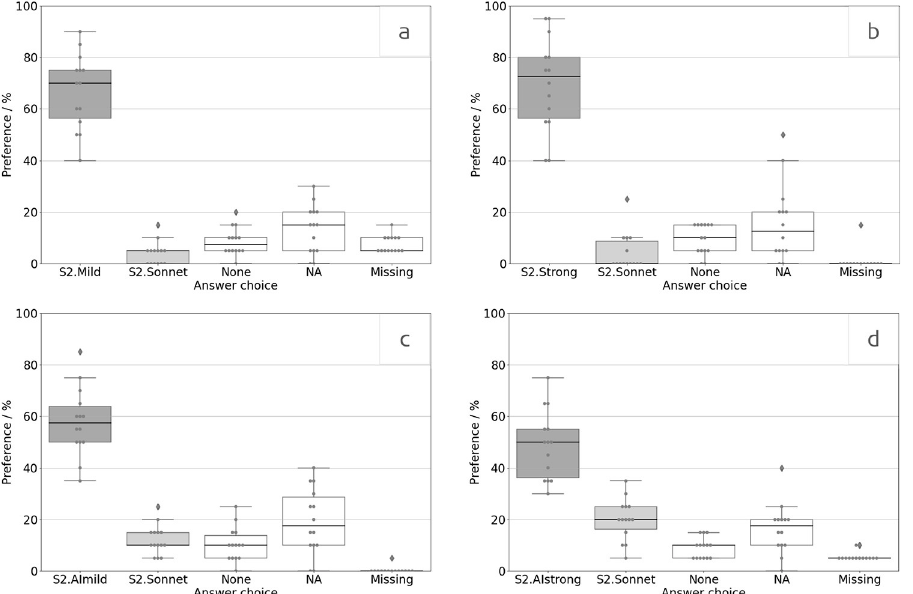
Fig 7. Product-specific questionnaire results. Figures are the S2.Sonnet vs. 7a) S2.Mild, 7b) S2.Strong, 7c) S2.AImild, 7d) S2.AIstrong. A point indicates that this percentage of users preferred either the SONNET 2 configuration given on the abscissa, had no preference (None), found the question not applicable (NA), or did not rate (Missing) for the specific listening environment. Higher scores indicate greater preference. Diamonds indicate